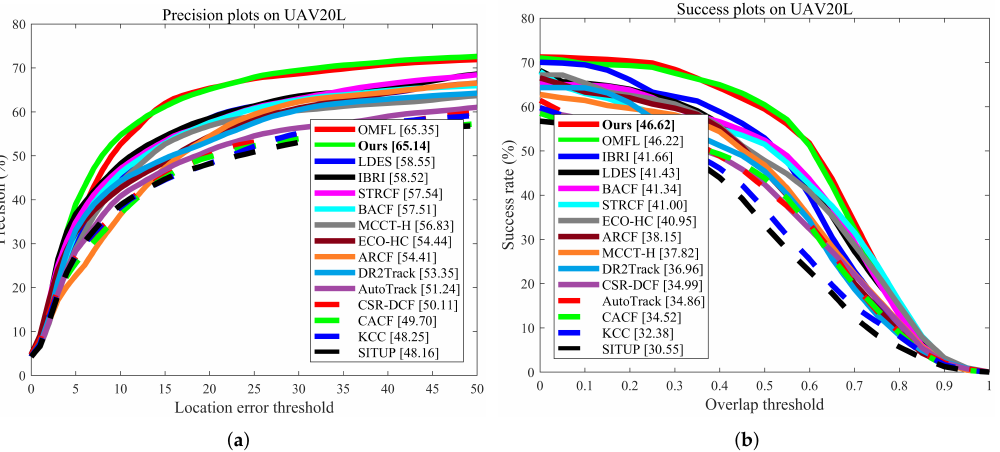
Figure 8. Overall evaluation on the UAV20L [45] benchmark. ( a ) Precision plots. ( b ) Success plots.